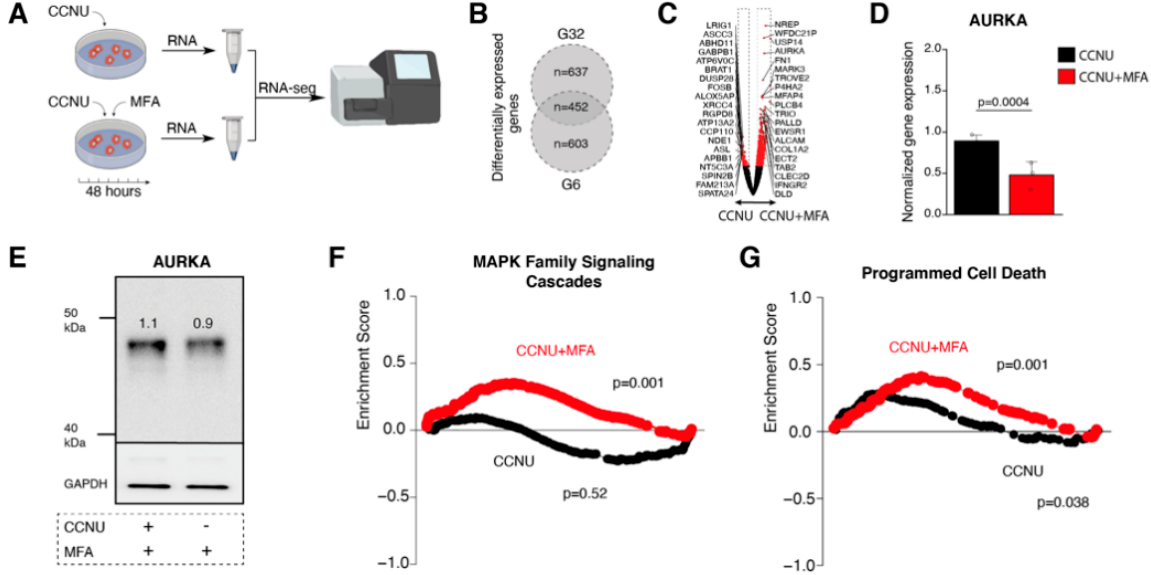
Figure 6. Meclofenamate-mediated sensitizing effects are accompanied by reduced Aurora kinase A expression and elevated programmed cell death pathway signaling. ( A ) Workflow illustration. After cells were treated with CCNU and the combination of CCNU and MFA for 48 h, RNA sequencing was performed. ( B ) Venn diagram depicting the number of differentially expressed genes of G6 and G32 cell populations separately and the number of shared differentially expressed genes. ( C ) Volcano plot of differentially expressed genes in CCNU monotreatment vs. combination treatment. ( D ) Barplot of AURKA expression. ( E ) Western blot analysis and densitometric quantification of AURKA protein expression. ( F , G ) Gene Set Enrichment Analysis of MSigDM REACTOME_MAPK_Family_Signaling_Cascades Pathway. ( F ) and REACTOME_Programmed_Cell_Death Pathway. ( G ) CCNU monotreatment compared to the untreated control is marked in black whereas CCNU monotreatment compared to combination treatment with MFA is marked in red. AURKA, Aurora kinase A; CCNU, lomustine; MFA, meclofenamate.